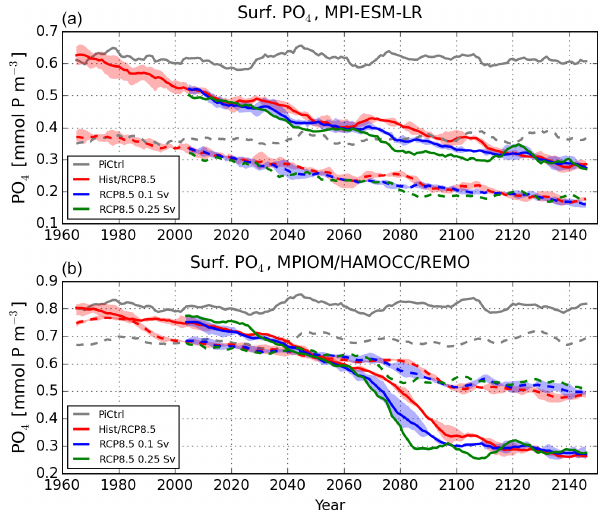
Figure 16. Pre-bloom (March) surface phosphate concentration in the NE Atlantic (solid; 45–62 ◦ N, 5–20 ◦ W) and the northern North Sea (dashed; northern boundary: Orkney–Shetland and Shetland– Norway at 60.4 ◦ N; southern boundary: 50m isobath), simulated by the parent global model MPI-ESM-LR (a) and the downscal- ing model system MPIOM/HAMOCC/REMO (b) . Lines: control run C0 (gray), ensemble means of experiments E0 (red) and E010 (blue), and single realization of experiment E025 (green). Shaded areas: ensemble